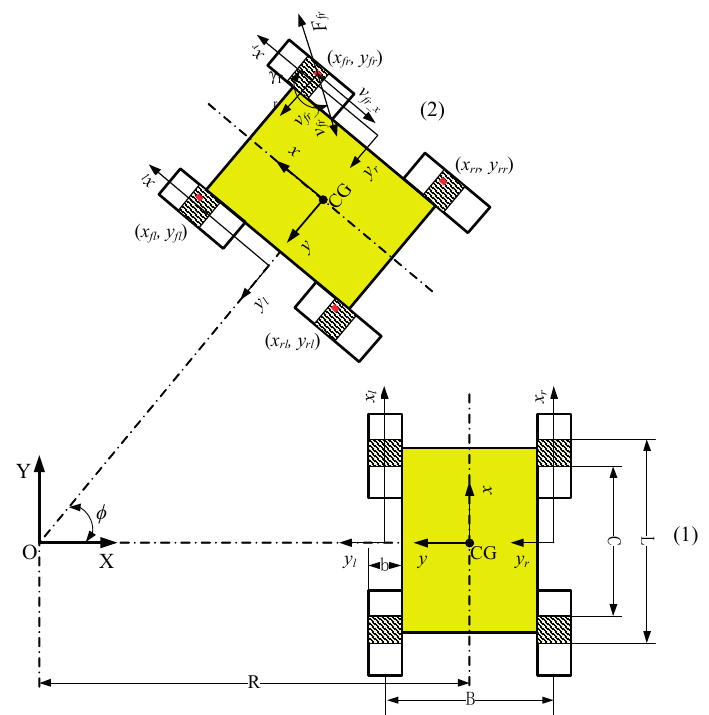
Figure 4. Motion of the skid-steering mobile robot wheel element on the lab surface (firm ground) from position (1) to (2).